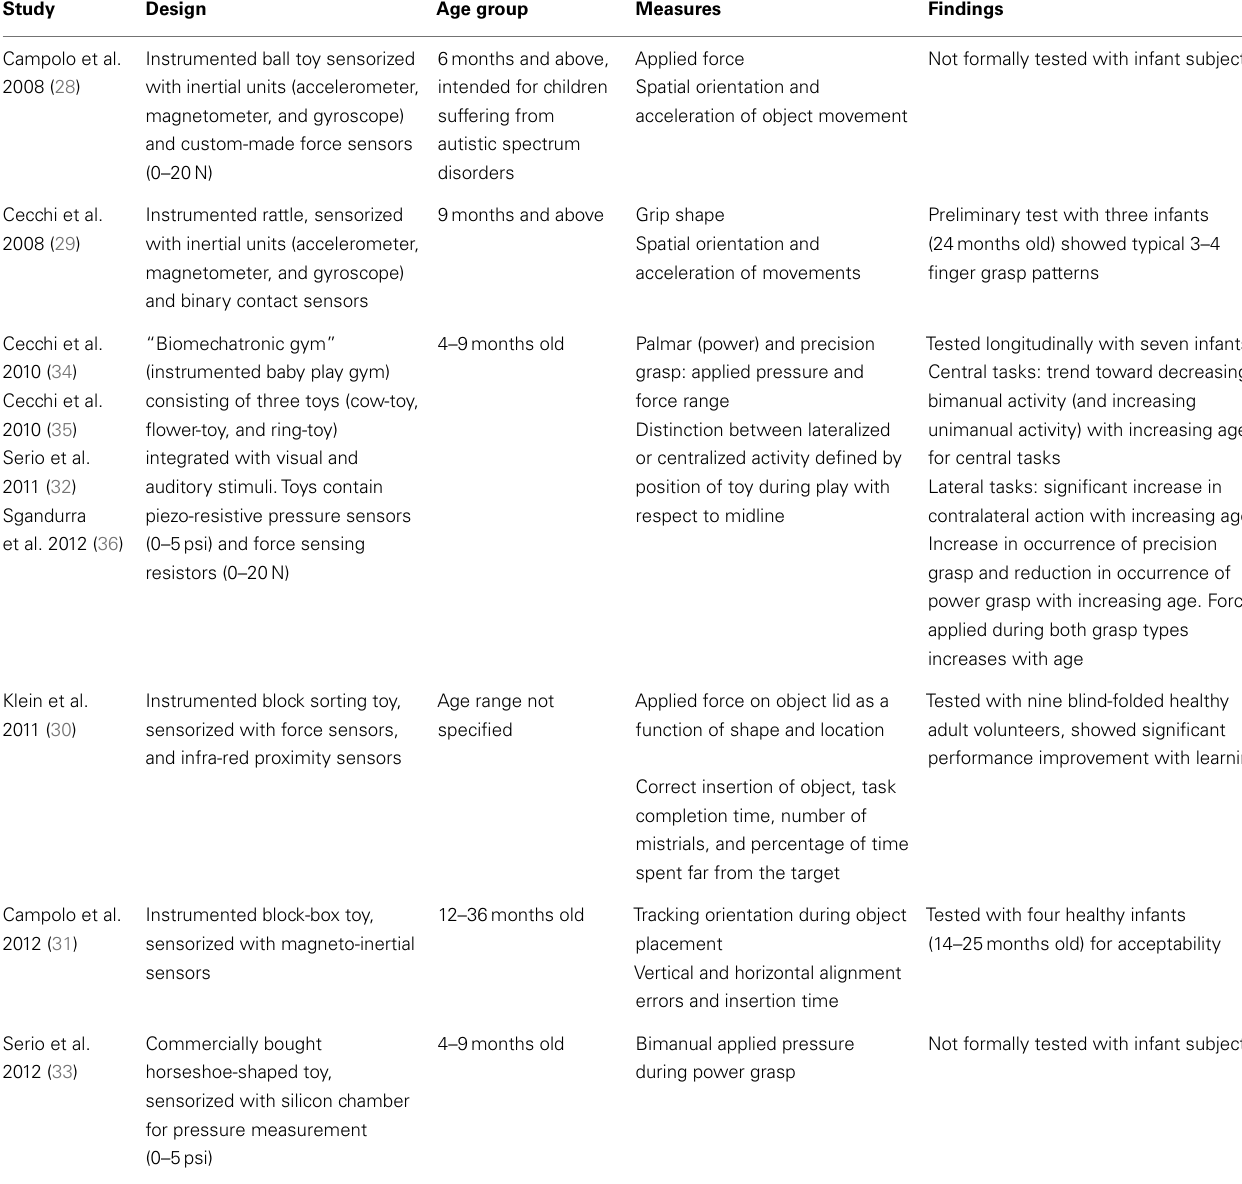
Table 1 | Summary of studies that have developed instrumented toys to quantitatively assess movement in young children